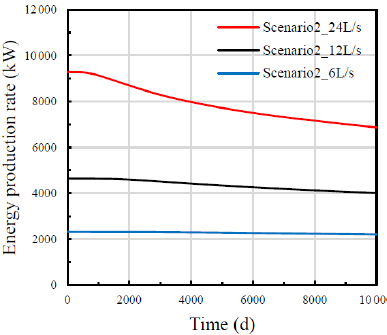
Figure 12. Evolution of energy production with time for three flow rates (Scenario